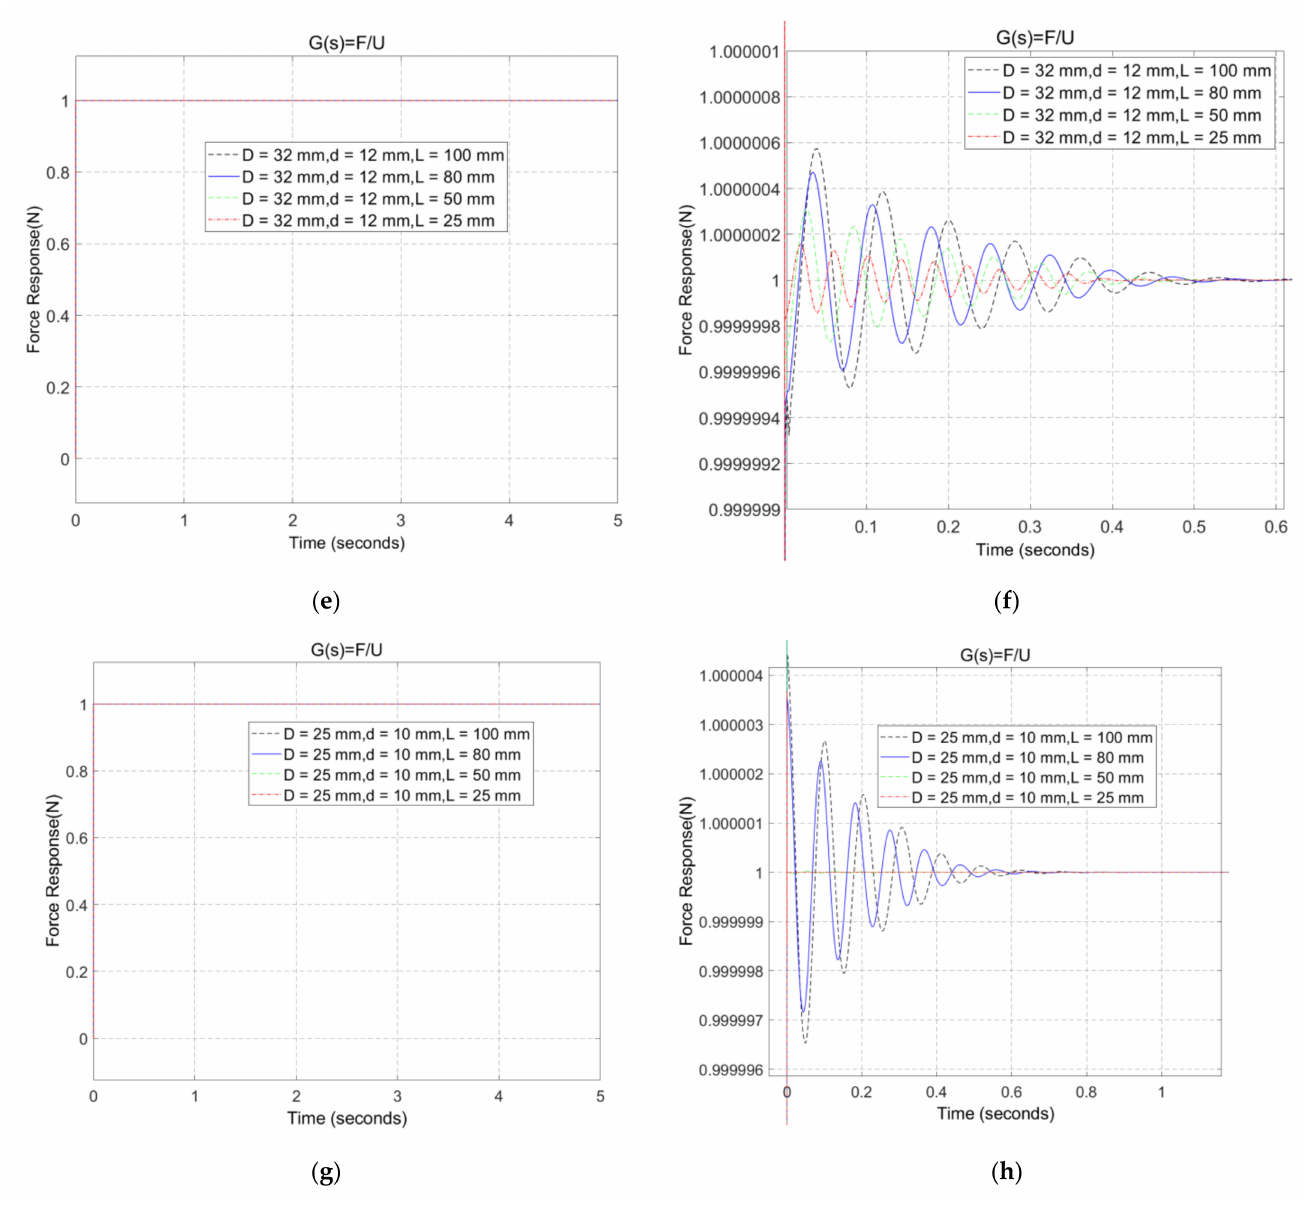
Figure 9. Response curves of the output force at different strokes. ( a ) D = 80 mm, d = 25 mm; ( b ) D = 50 mm, d = 25 mm (partial enlarged view at the initial stage); ( c ) D = 50 mm, d = 20 mm; ( d ) D = 50 mm, d = 20 mm (partial enlarged view at the initial stage); ( e ) D = 32 mm, d = 12 mm; ( f ) D = 32 mm, d = 12 mm (partial enlarged view at the initial stage); ( g ) D = 25 mm, d = 10 mm; ( h ) D = 25 mm, d = 10 mm (partial enlarged view at the initial